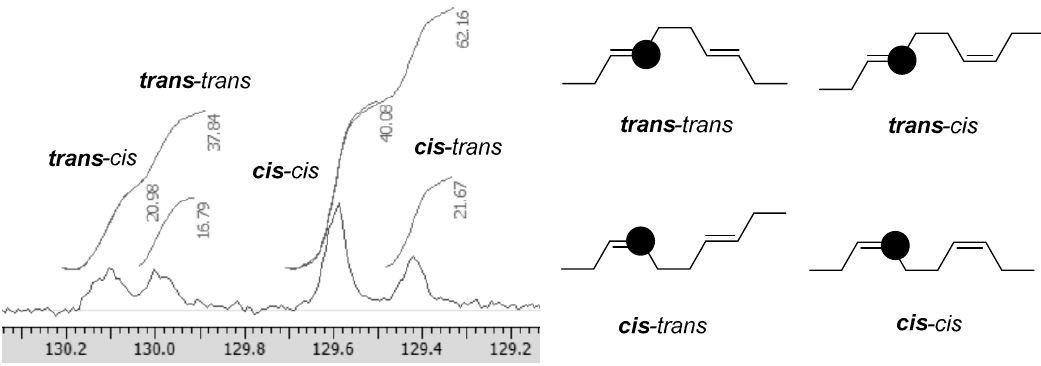
Figure 2. 13 C NMR spectrum of polybutadiene (Table 1, Run 2, 125 MHz, in CDCl 3 ).